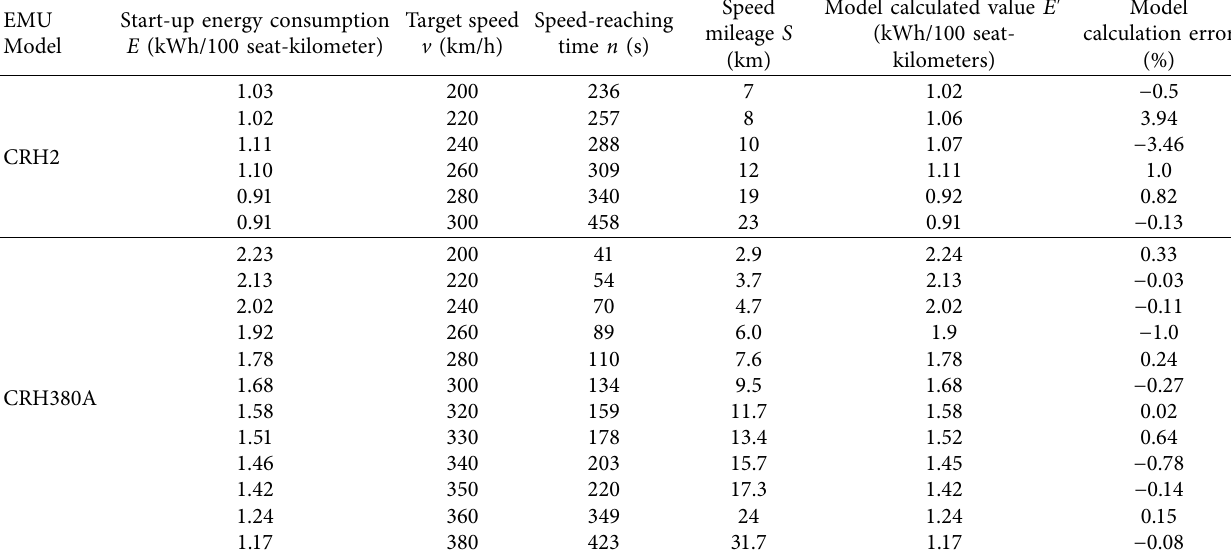
Table 7: Analysis of the start-up energy consumption of CRH2 and CRH380A EMUs. EMU